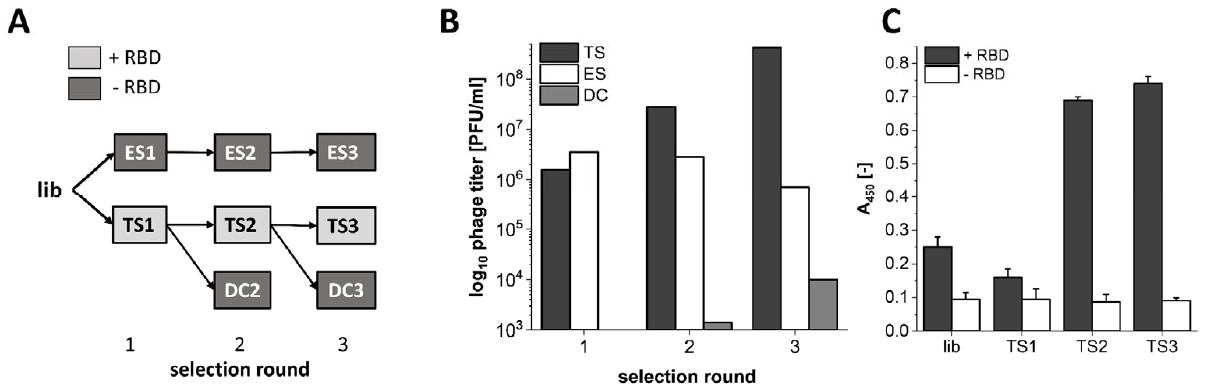
Figure 1. M13 phage display selection on SARS ‐ CoV ‐ 2 RBD in three consecutive selection rounds. ( A ) Selection scheme: lib = naïve library; TS = target selection on RBD; DC = direct control; ES = empty selection. Samples are derived from each other in the direction of the connecting arrow start ‐ ing with the naïve phage display library (lib). For TS, the selection target SARS ‐ CoV ‐ 2 RBD was immobilized on a streptavidin ‐ functionalized surface, while no target protein was immobilized for ES and DC. ( B ) Output phage titer in PFU/mL for selection samples of TS, ES and DC as measured past phage elution after biopanning. ( C ) Enrichment ELISA with input titer samples on the immo ‐ bilized SARS ‐ CoV ‐ 2 RBD selection target protein. Phage concentration was adjusted based on A 265 UV ‐ vis measurements to a total input of 2.5 × 10 10 phages for all samples.